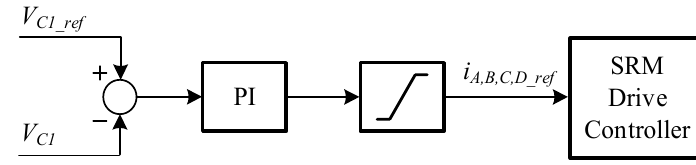
Figure 6. Voltage controller associated with the SRM drive.